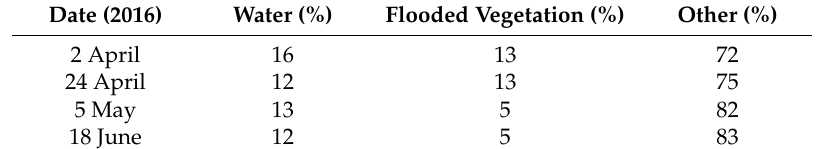
Table 4. Percentages of each class identified for each Kennaugh Element model through time.